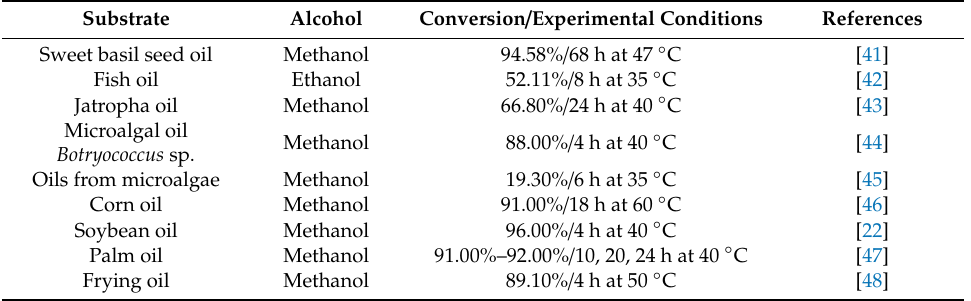
Table 1. Application of Novozym 435 in the transesterification reaction for biodiesel